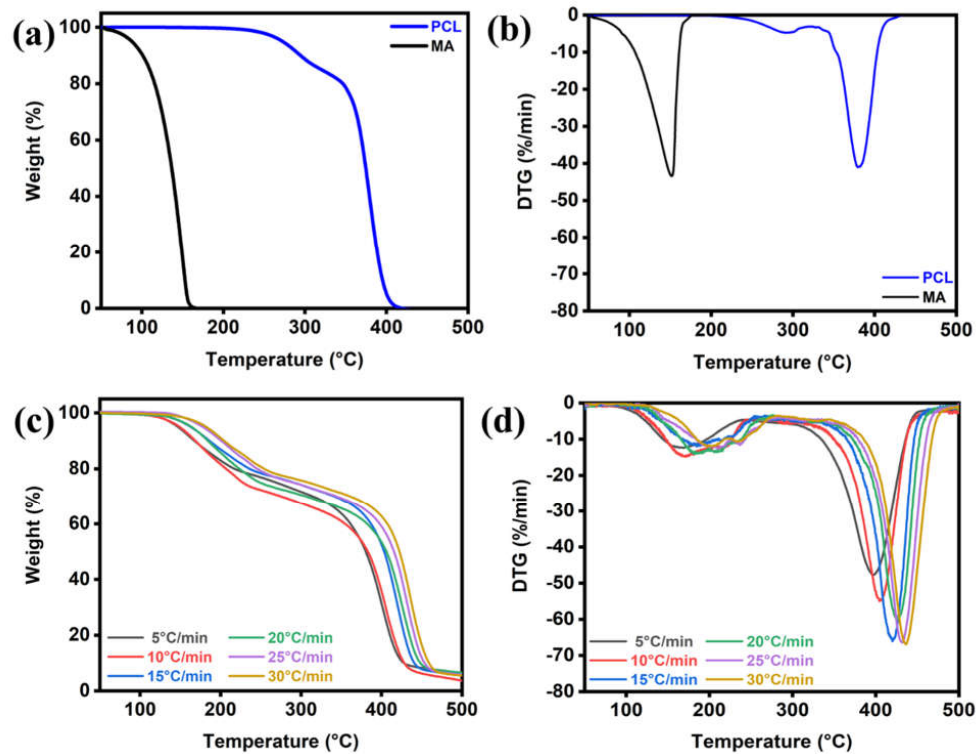
Figure 6. ( a ) Thermograms and ( b ) DTG curves of PCL and MA, and ( c ) thermograms and ( d ) DTG curves of PCL−g−MA at a maximum grafting ratio all at various heating rates.